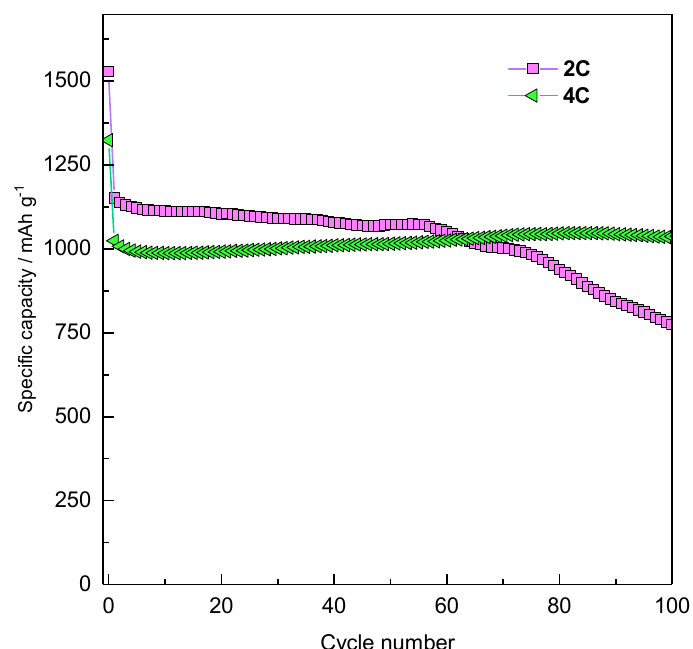
Figure 6. Fe 3 O 4 /rGO performances at 2C and 4C rate. The tests were performed at 1762 and 3524 mA g − 1 (2C and 4C, respectively), in the potential window within 0.001–3.000 V.